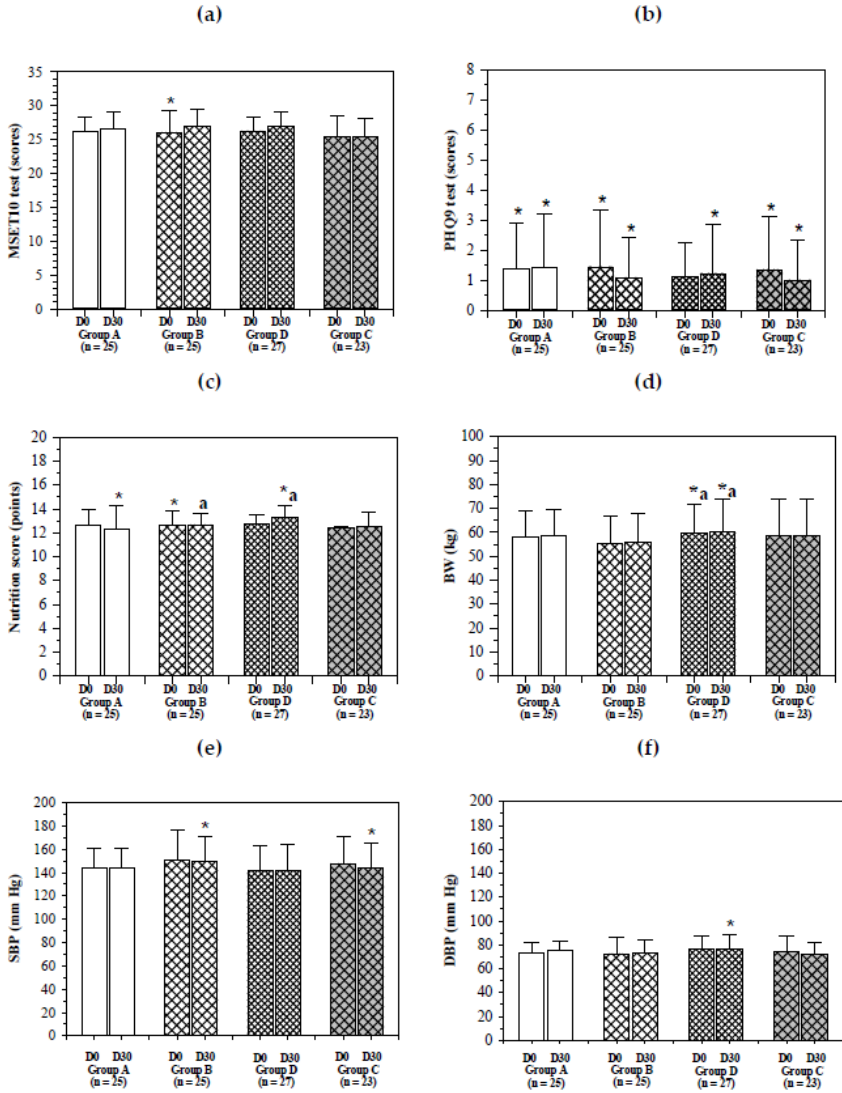
Figure 2. Changes in neurological and nutritional scores, body weight and blood pressure values in elderly subjects. Non-anemic elders consumed the WR drink (2 mg iron/100 mL serving) (group A), IR drink (15 mg iron/100 mL serving) (group B) and the IR drink (27 mg iron/100 mL serving) (group D), while anemic elders (group C) consumed the IR drink (15 mg iron/100 mL serving) for 30 days and reported MMSE Thai 2002 ( a ), PHQ9 ( b ) and nutritional ( c ) scores, BW ( d ) and BP ( e , f ) values. Data are expressed as mean ± standard deviation (SD) values. * Shapiro–Wilk W test ( p < 0.05). a Wilcoxon signed rank-sum test p < 0.05 when members of the same group were compared before and after the study. Abbreviations: BW = body weight, BP = blood pressure, DBP = diastolic blood pressure, Hg = mercury, IR = iron rice, MMSE Thai 2002 = Mini Mental State Examination Thai 2002, PHQ9 = Patient Health Questionnaire 9, SBP = systolic blood pressure, WR = white